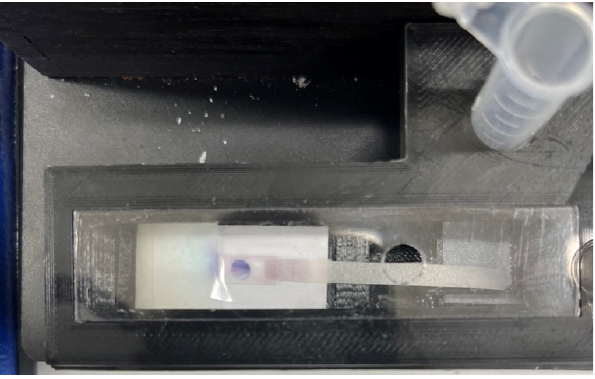
Figure 10. A signal formed in the detection zone for detection of 50 ng/mL of rabbit IgG in buffer.